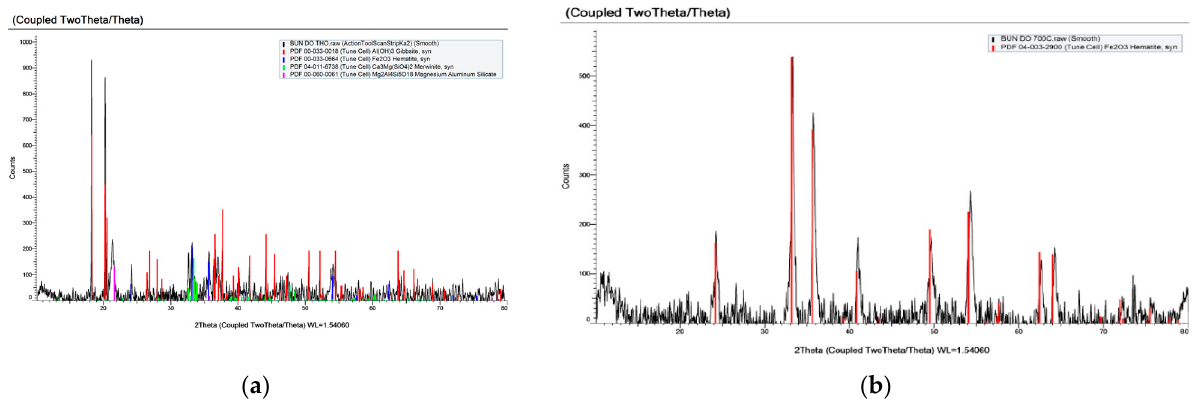
Figure 7. ( a ) XRD pattern of red mud before calcined; ( b ) XRD pattern of red mud after calcined.